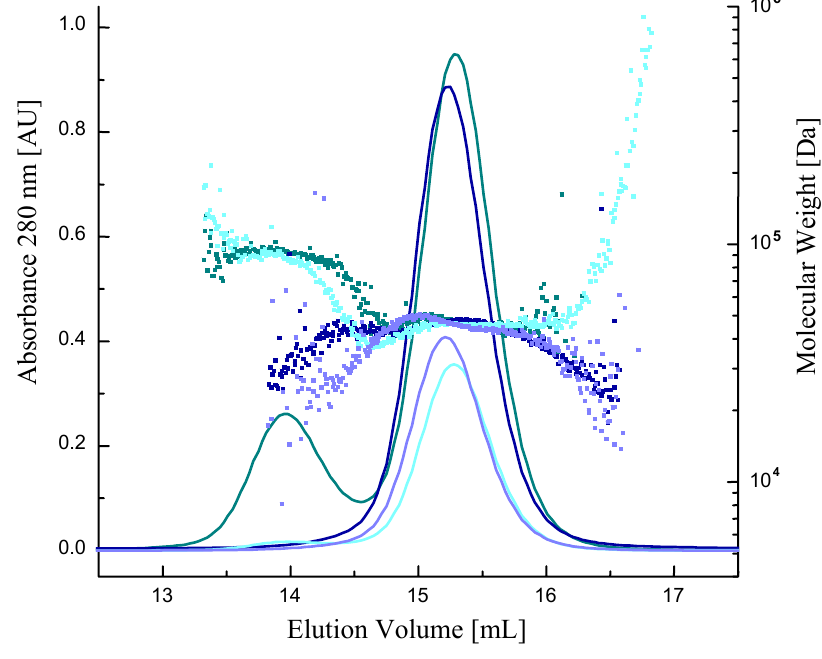
Figure 4. Gel-filtration light-scattering analysis of Case12. The solid lines represent the signals of the eluted proteins at 280 nm and the small squares represent the calculated molecular masses obtained from the multi-angle light scattering measurements. The colors are coded as following: dark green—Case12 at 16 mg/mL + Ca 2+ ; dark blue—Case12 at 16 mg/mL + EGTA; cyan—Case12 at 4 mg/mL + Ca 2+ ; light blue—Case12 at 4 mg/mL + EGTA.